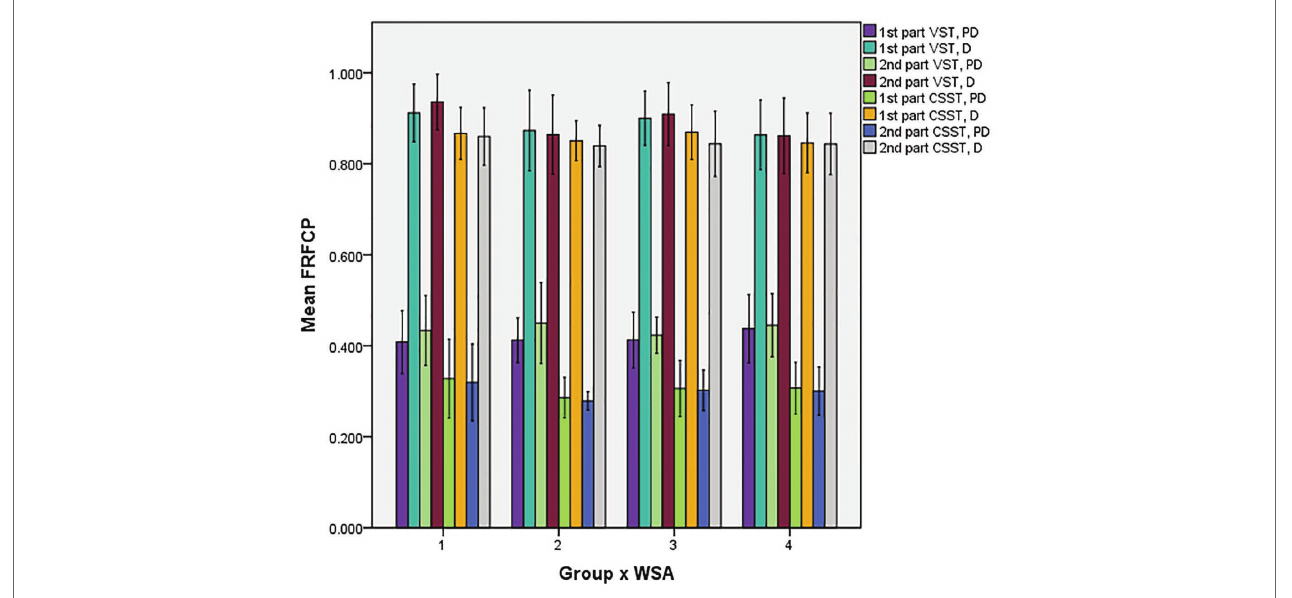
FIGURE 5 | Bar chart of differences of FRFCP in all conditions. PD, pre-distractor; D, distractor; Condition 1, PG with EP feedback; Condition 2, PG with ER feedback; Condition 3, RG with EP feedback; Condition 4, RG with ER